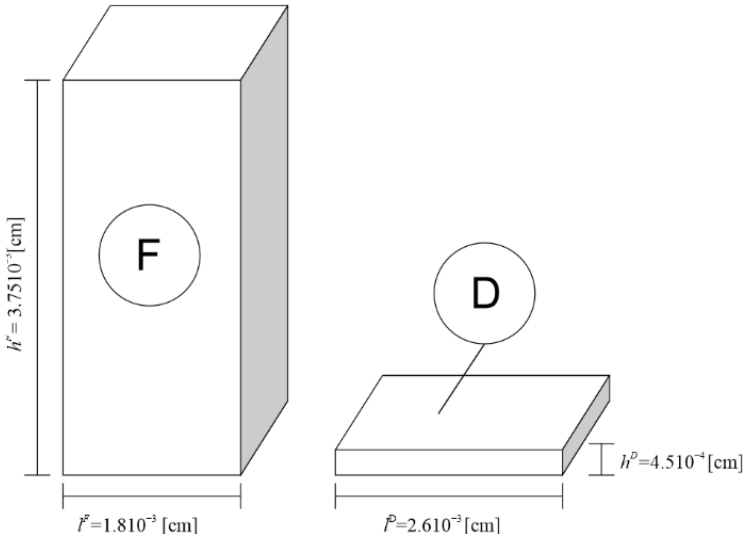
Tympanic cavity ;